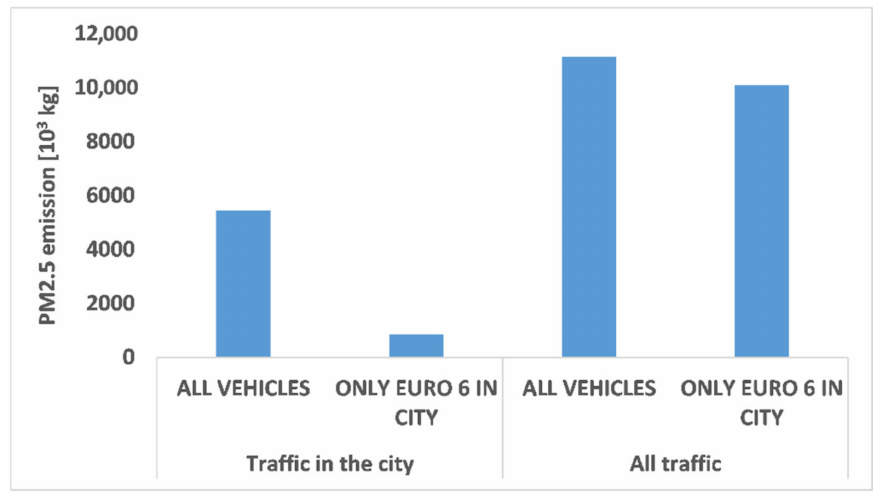
Figure 21. Comparison of PM2.5 emissions from all vehicles and Euro 6 vehicles only in an urban area. The case of the second scenario showed that the conversion impacted